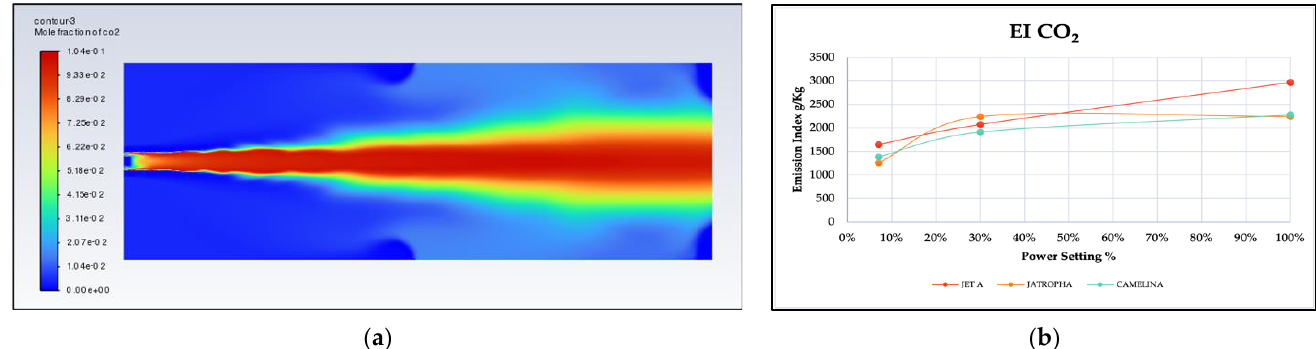
Figure 9. CO 2 emissions’ simulation results from camelina biofuel combustion: ( a ) the mass fraction of CO 2 while burning camelina at 100% power; ( b ) the emission index of CO 2 versus the power setting for the simulated fuels.